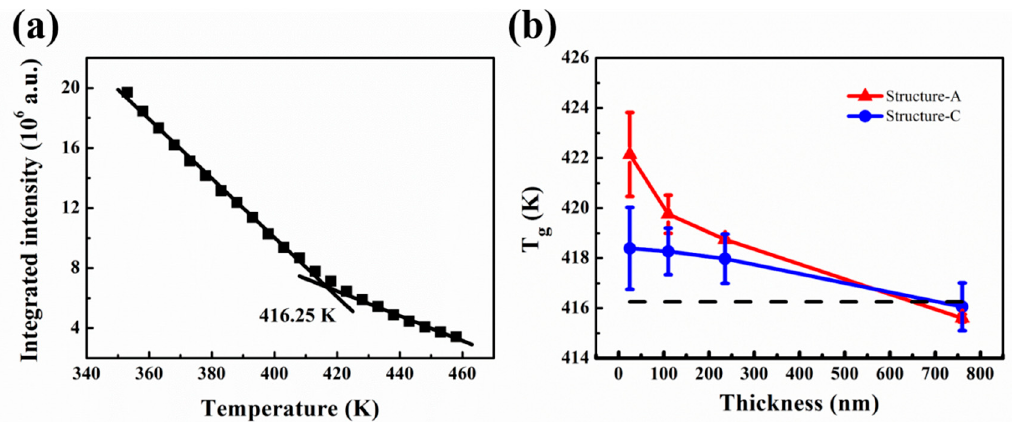
Figure 3. ( a ) Temperature dependence of the integrated intensity of TC1-labeled PMMA bulk film. ( b ) The spatial T g of different thickness of TC1-labeled PMMA film for structure-A and structure-C: the T g s of each three films in the plot are defined by its average temperature. The dashed lined indicates the T g of bulk TC1-labeled PMMA film supported on quartz substrate.